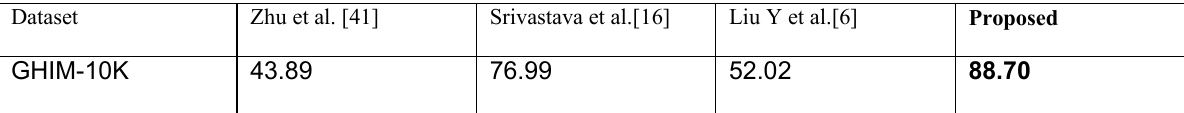
Table 3. Comparison of Average precision of proposed method with other methods for GHIM-10 K database